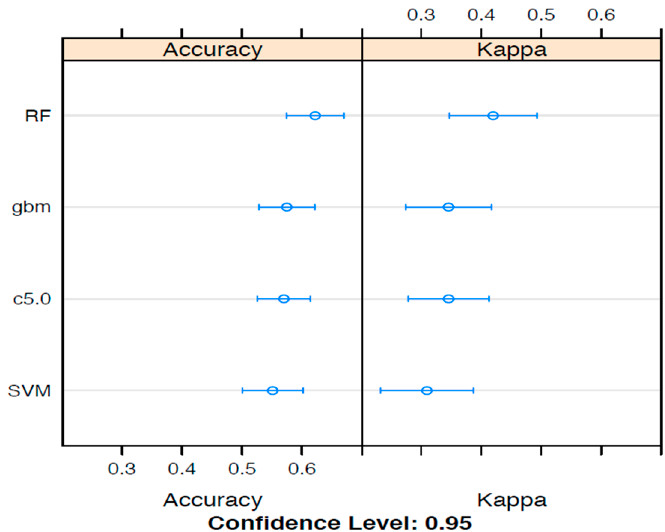
Figure 1. A variety of machine learning ensembles compared to assess performance for ME/CFS WST (0, 1, 2) class prediction, as measured by percentage accuracy and the Kappa statistic. Boosting strategies applied to enhance machine learning performance for ensemble random forest (RF), gradient boosting (gbm), c5.0 tree construction and support vector machines (SVM).